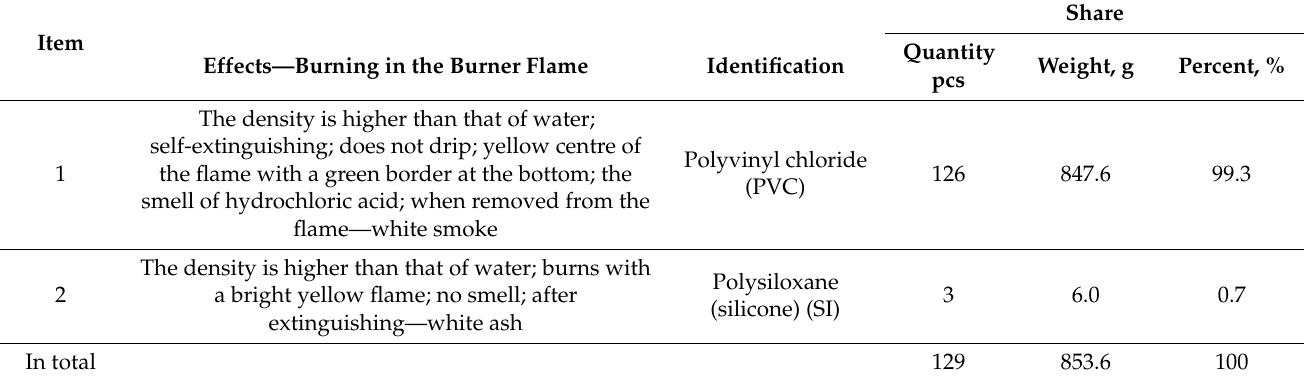
Table 1. Results of identification and mass measurements of the waste delivered for testing.